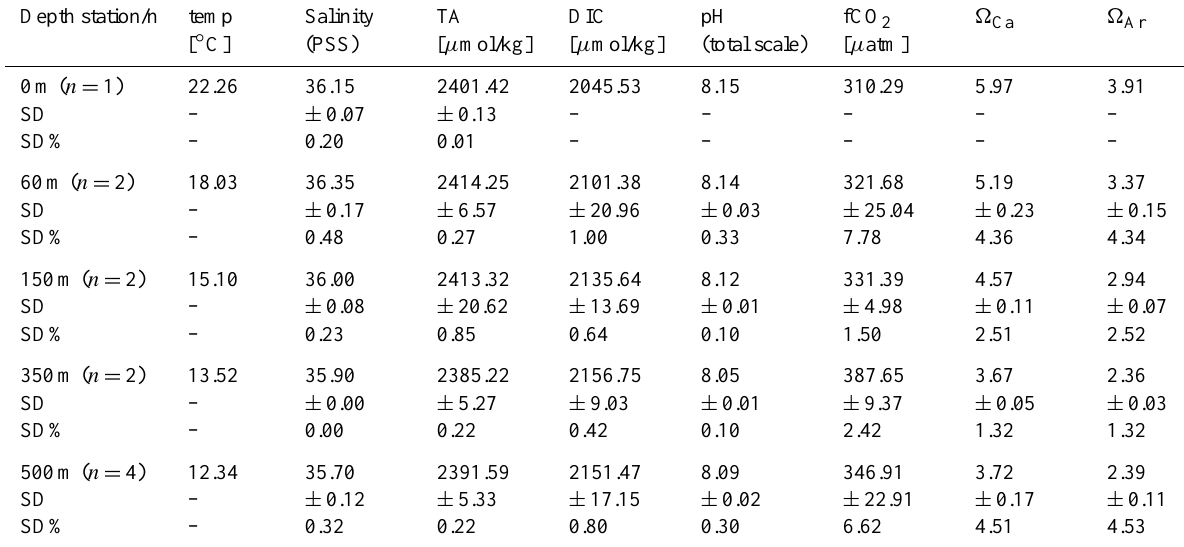
Table 3. Computed carbonate system parameters (pH, fugacity, and saturation states for calcite and aragonite) based on the given measure- ments of temperature, salinity, total alkalinity and total dissolved inorganic carbon. Mean values are given per depth station together with the absolute and percentaged standard